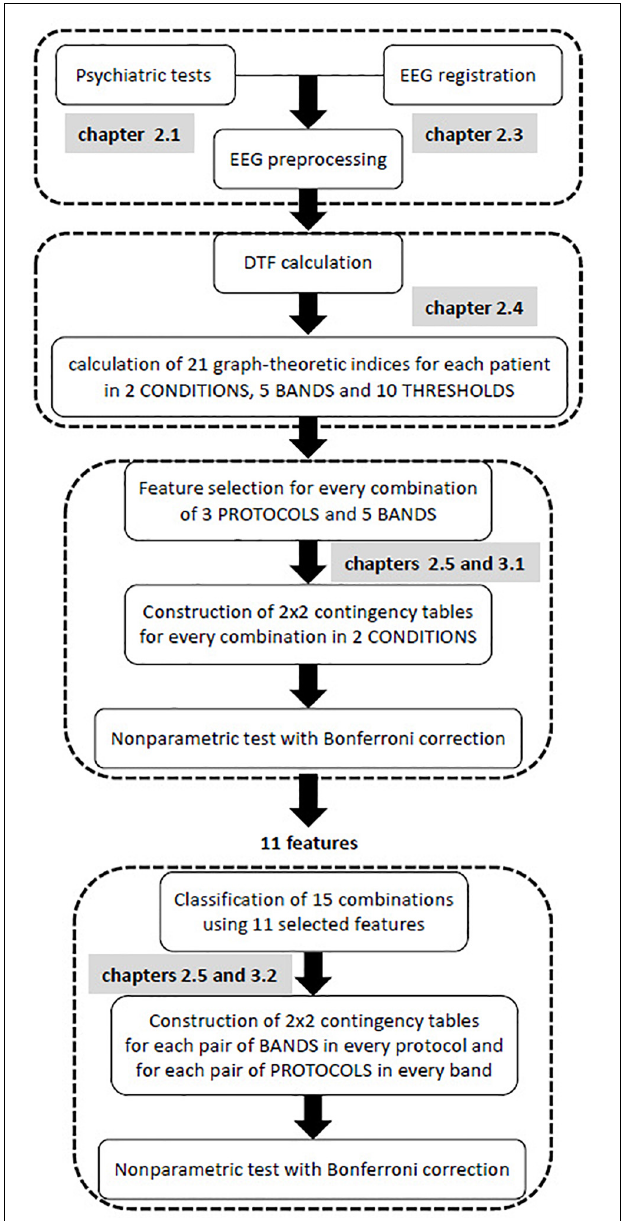
FIGURE 1 | Flow chart of all stages of EEG